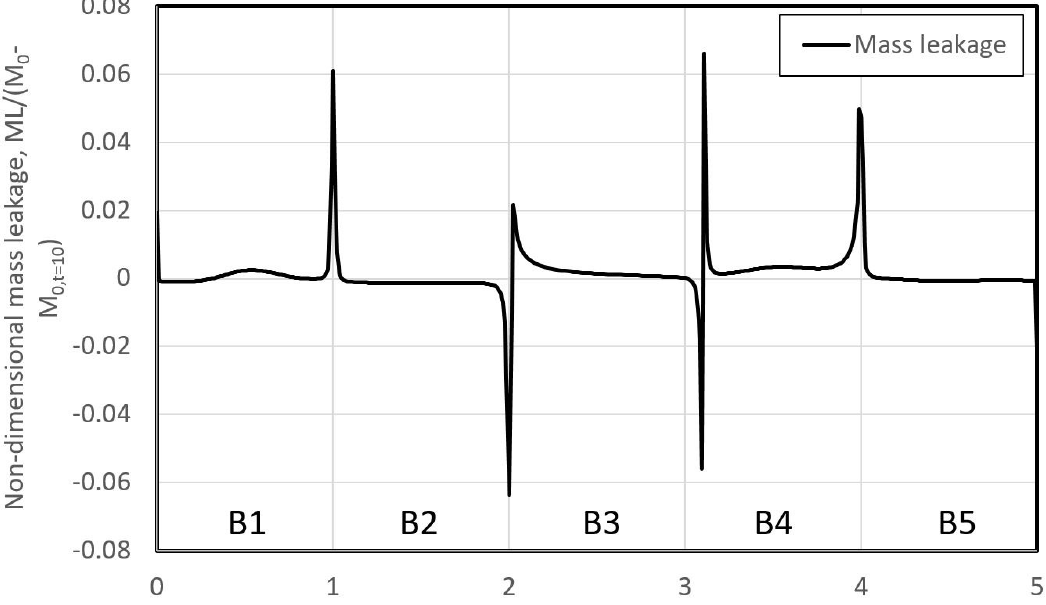
Figure 9. Non-dimensional ML along the left boundary of the multiple bending